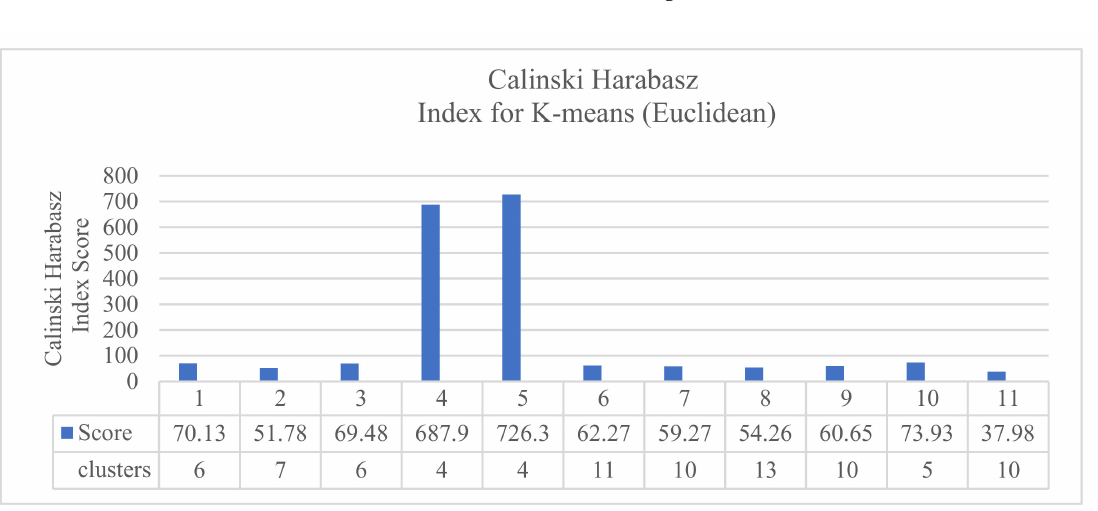
Figure 3. The results of Calinski–Harabasz scores for k-means Euclidean distance.